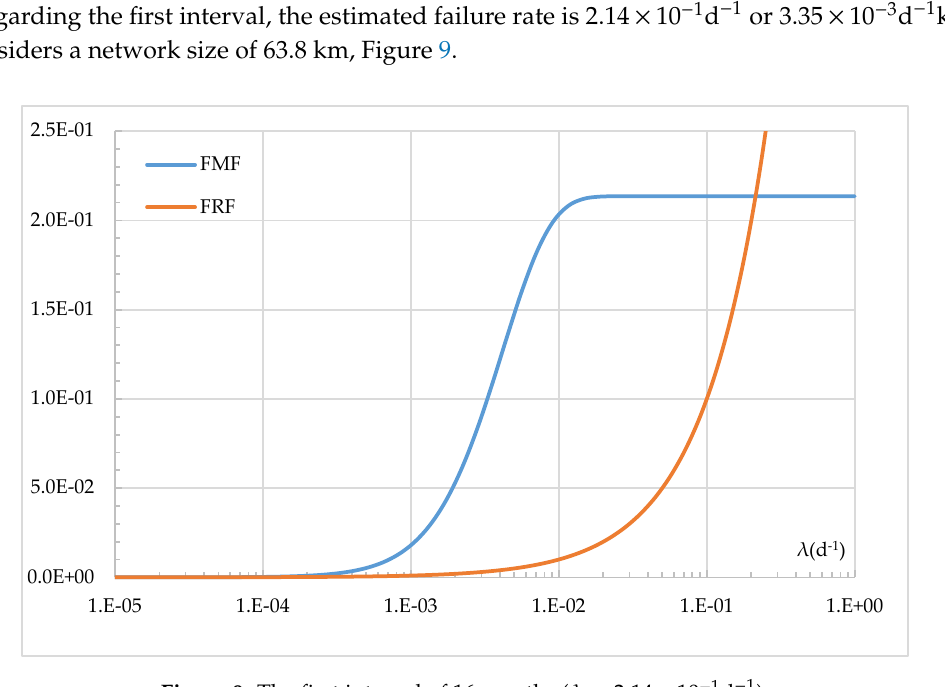
Figure 9. The first interval of 16 months ( λ = 2.14 × 10 − 1 d